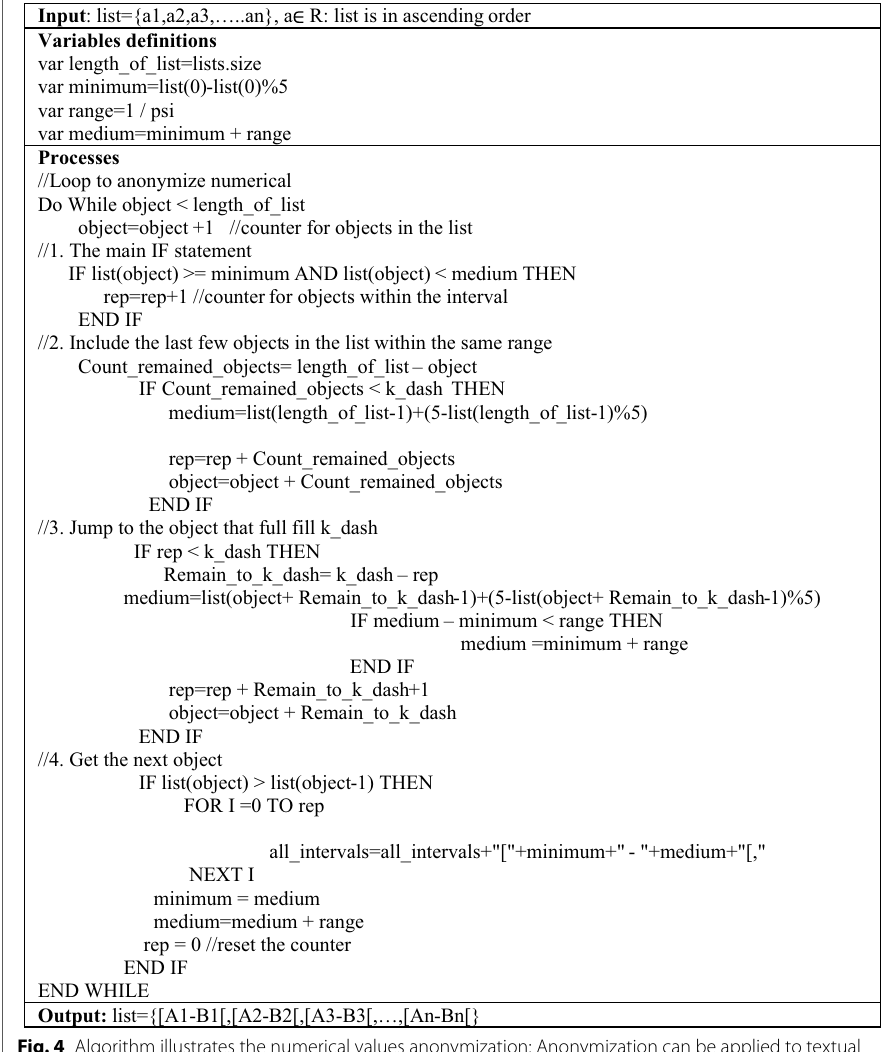
Fig. 4 Algorithm illustrates the numerical values anonymization: Anonymization can be applied to textual and/or numerical attributes. Here in this algorithm, the numerical anonymization is denoted by an interval that replaces one digital